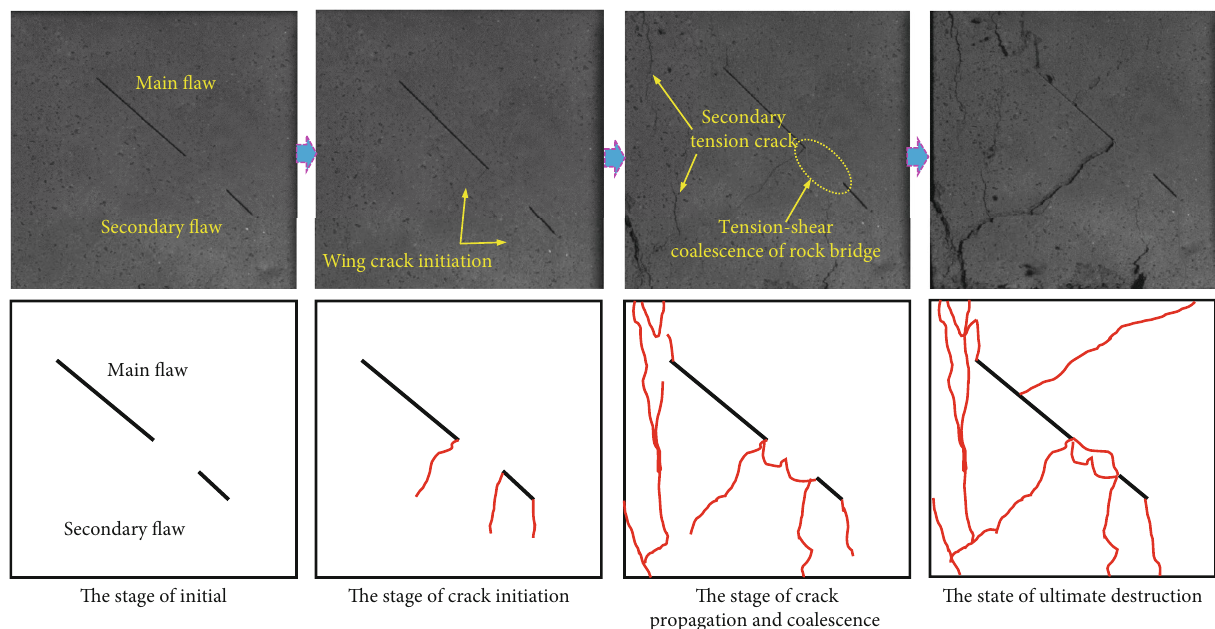
= 36 mm , 2 l = 12 mm , 2 d = 12 mm . 1 2